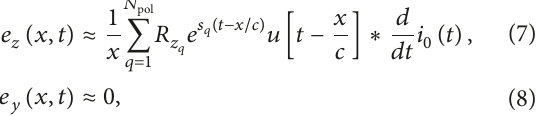
and 𝑅 𝑧 are the complex pole and the residues related to the 𝑞 𝑞 th resonant process taking place in the radiating